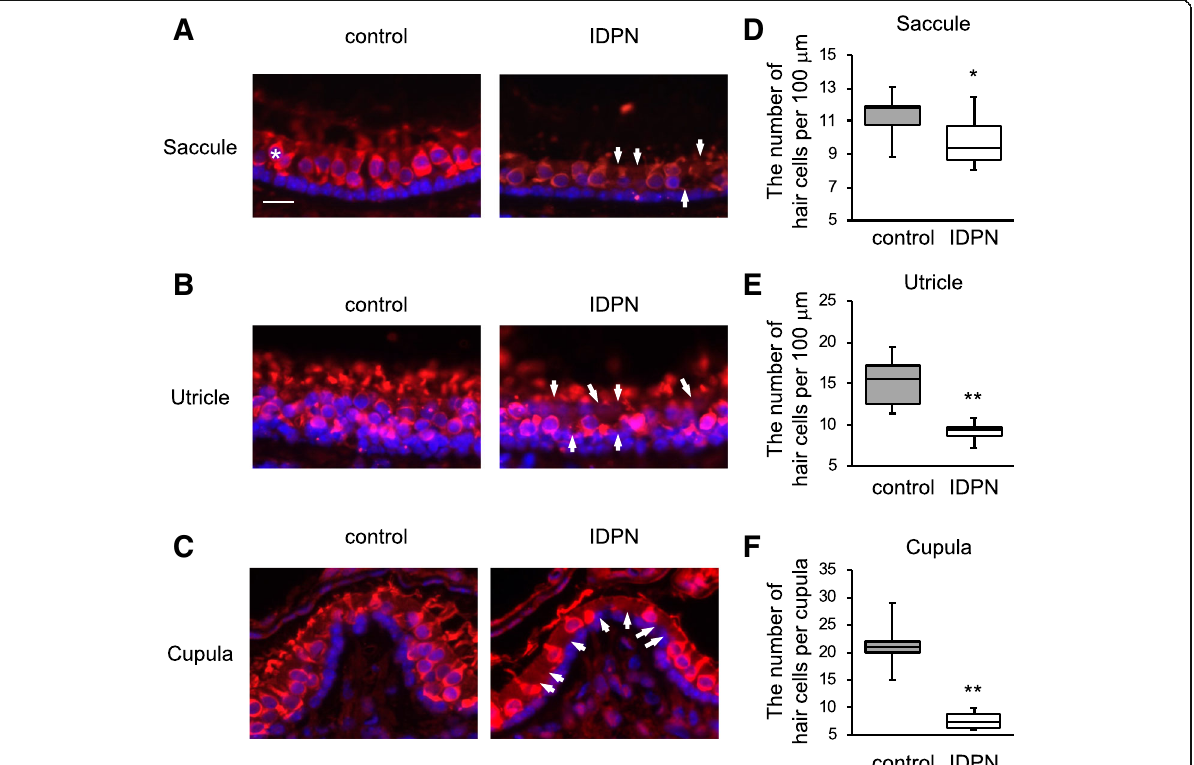
Fig. 2 Vestibular hair cell loss in the saccule, utricle, and cupula of mice treated with IDPN. a – c After administration of IDPN, hair cells were stained with anti-MyosinVIIa antibody. Equivalent positions in the saccule ( a ), utricle ( b ), and cupula ( c ) from mice in the control group (left panels) and mice in the exposure group (right panels) are shown with the same scale (scale bar 20 μ m in a ). An asterisk shows an example of normal hair cells ( a ), and arrows indicate loss of hair cells ( a – c , right panels). d , e Numbers of hair cells per 100 μ m (mean±SD) in the saccules ( d ) and utricles ( e ) from 3 mice in the control group (gray) and 3 mice in the IDPN group (white) are shown. f Numbers of hair cells in the cupula (means±SD) from three mice in the control group (gray) and 3 mice in the IDPN group (white) are shown. Significant differences (* p <0.05, ** p <0.01) between the two groups were analyzed by Welch ’ s t